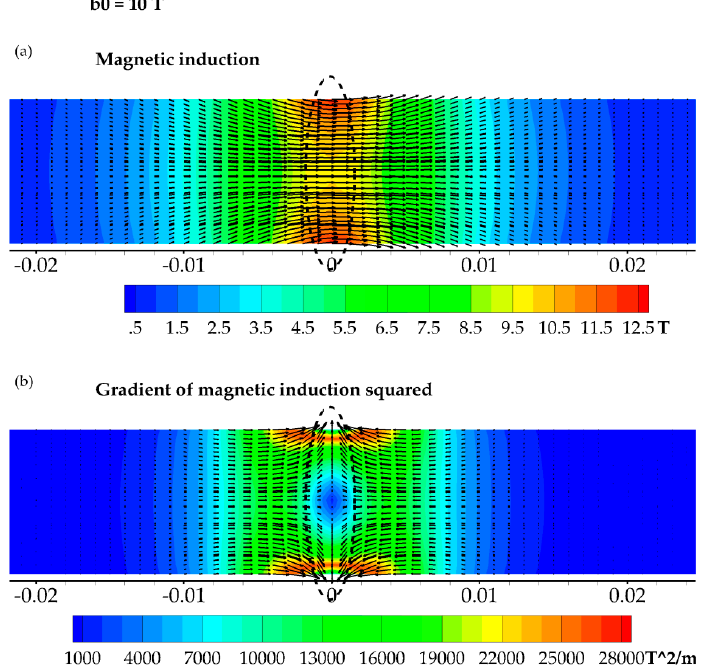
Figure 3. The distribution of magnetic field obtained in the computations: ( a ) Magnetic induction distribution, ( b ) gradient of magnetic induction squared.